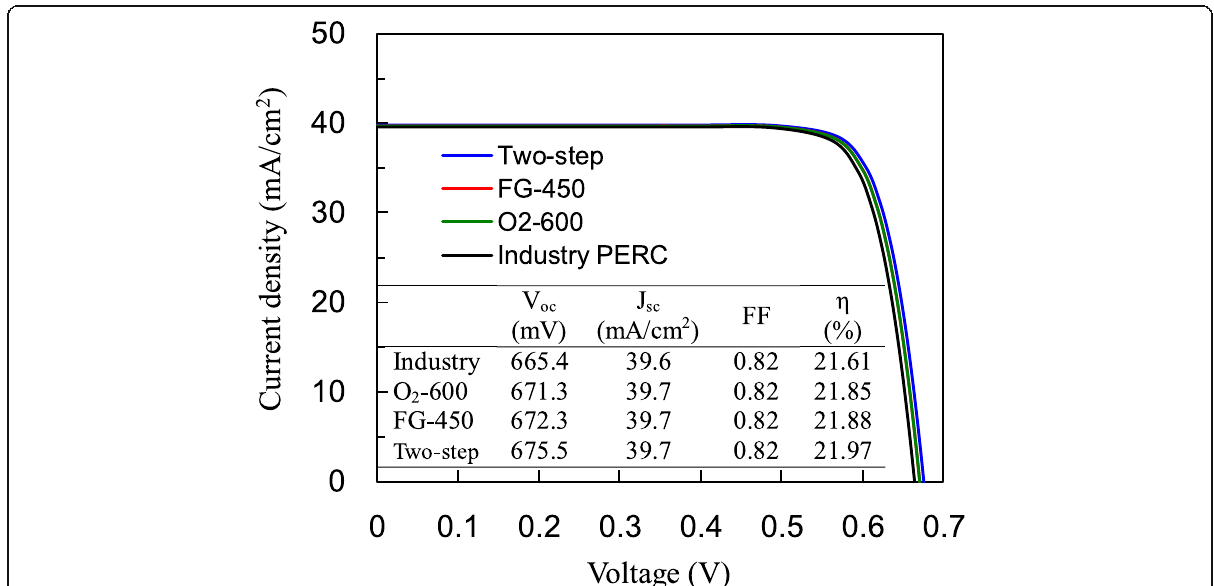
Fig. 7 Current density-voltage curves and photovoltaic performance of PERCs with industry standard fabrication, O 2 annealing, FG annealing, and two-step annealing